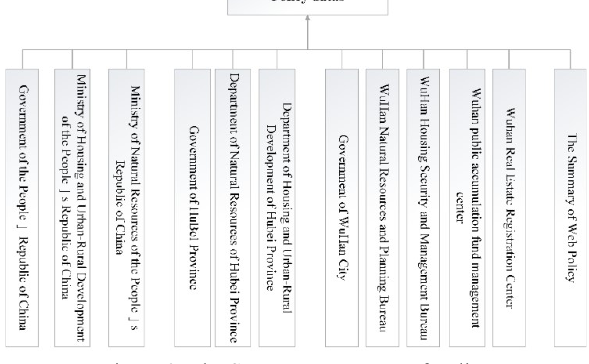
Figure 3. The Source Department of